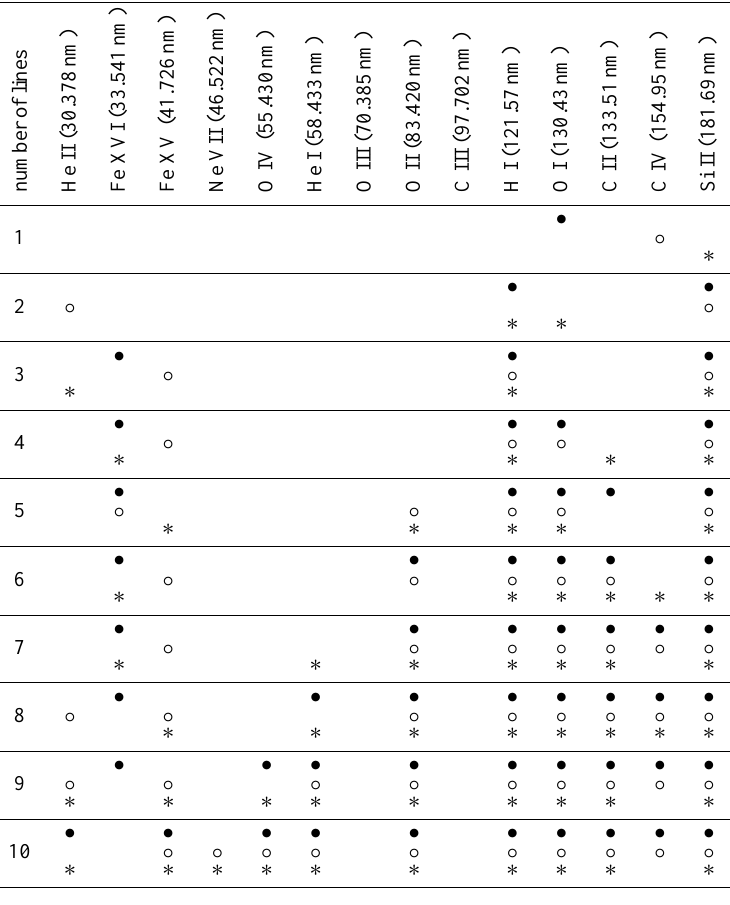
Table 4. The 3 best combinations for reconstruction the full EUV spectrum using 1 up to 10 spectral lines. These solutions minimise the absolute